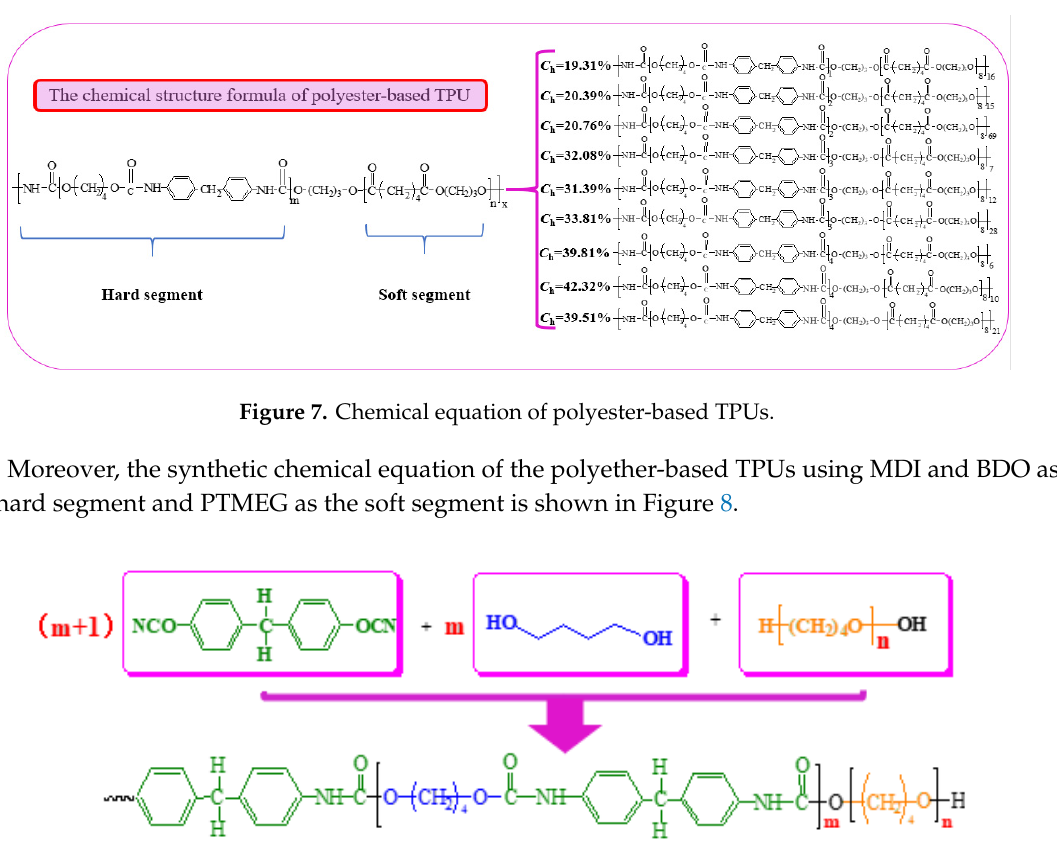
Figure 6. Chemical equation of MDI, BDO, and PBA synthetize polyester-based TPUs.